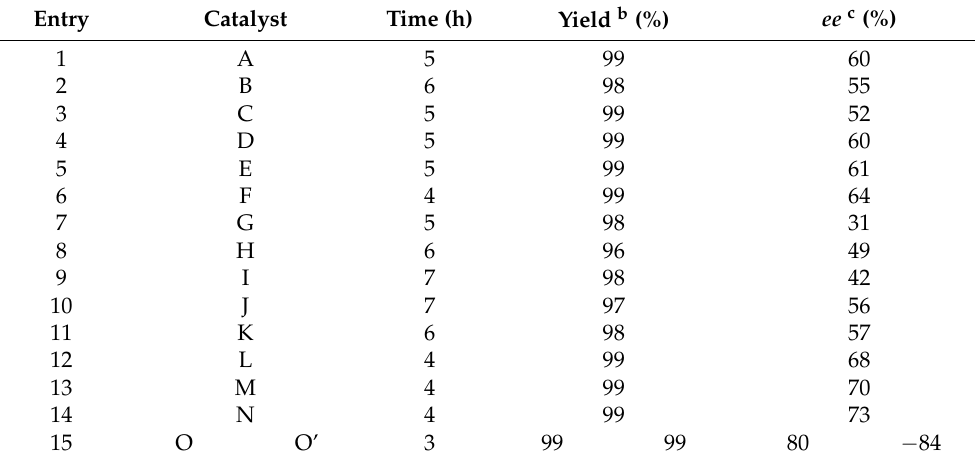
Figure 1. Cinchona phase-transfer catalysts A – O .